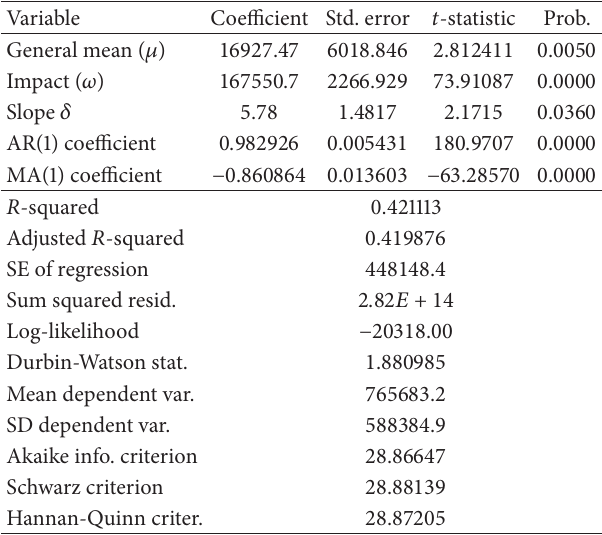
Table 4: Intervention ARIMA model parameter estimation.